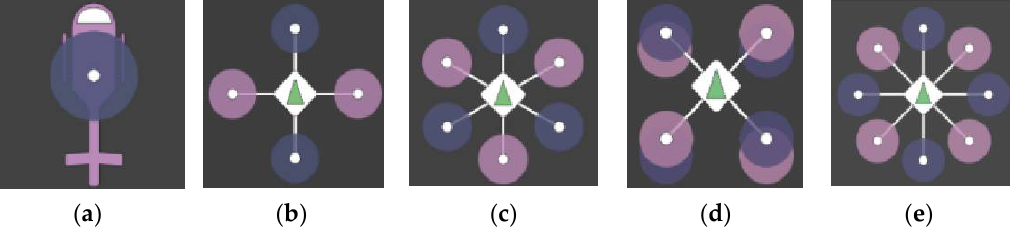
Figure 6. Types of drones: ( a ) Helicopter, ( b ) Quadrotor, ( c ) Hexarotor, ( d ) Octo Coax Wide, ( e ) Octorotor .